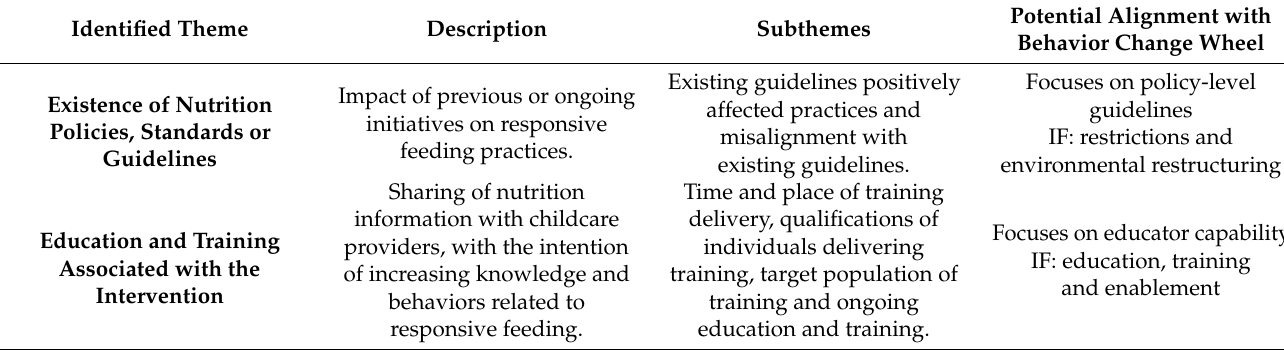
Table 3. Descriptions of Themes and